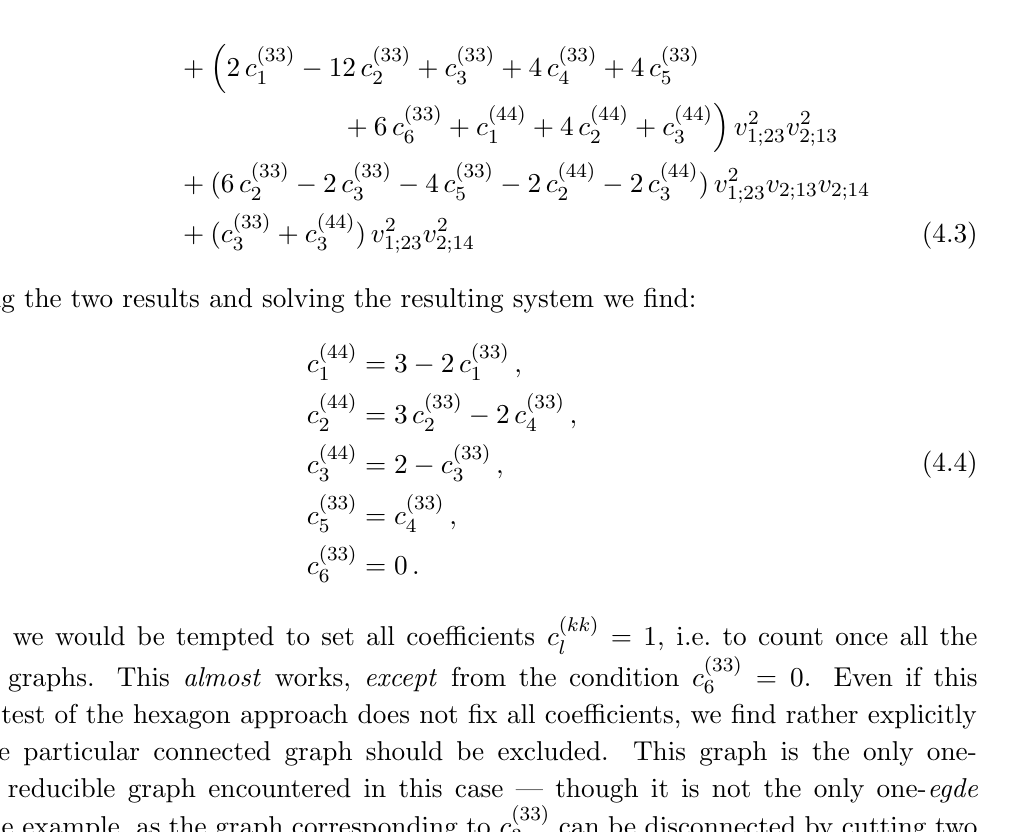
Figure 4 . A one-particle reducible four-point function. The lengths of the four operators that yield this graph are given by L 1 , L 2 = L 1 + 1, L 3 = L 4 + 1 and L 4